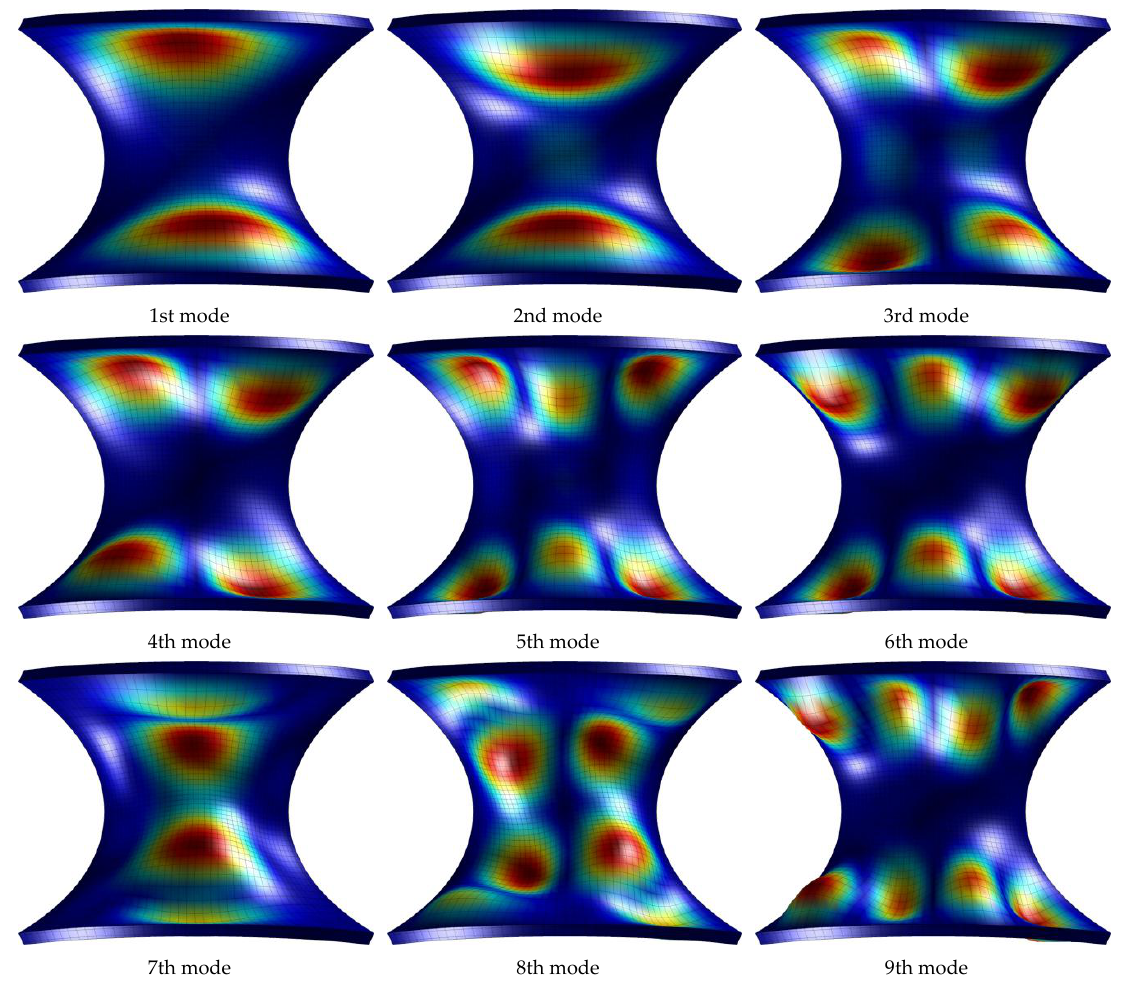
Figure 6. First nine mode shapes for a CCCC sandwich panel of revolution with ( 45/Core/ − 45 ) as lamination scheme. Table